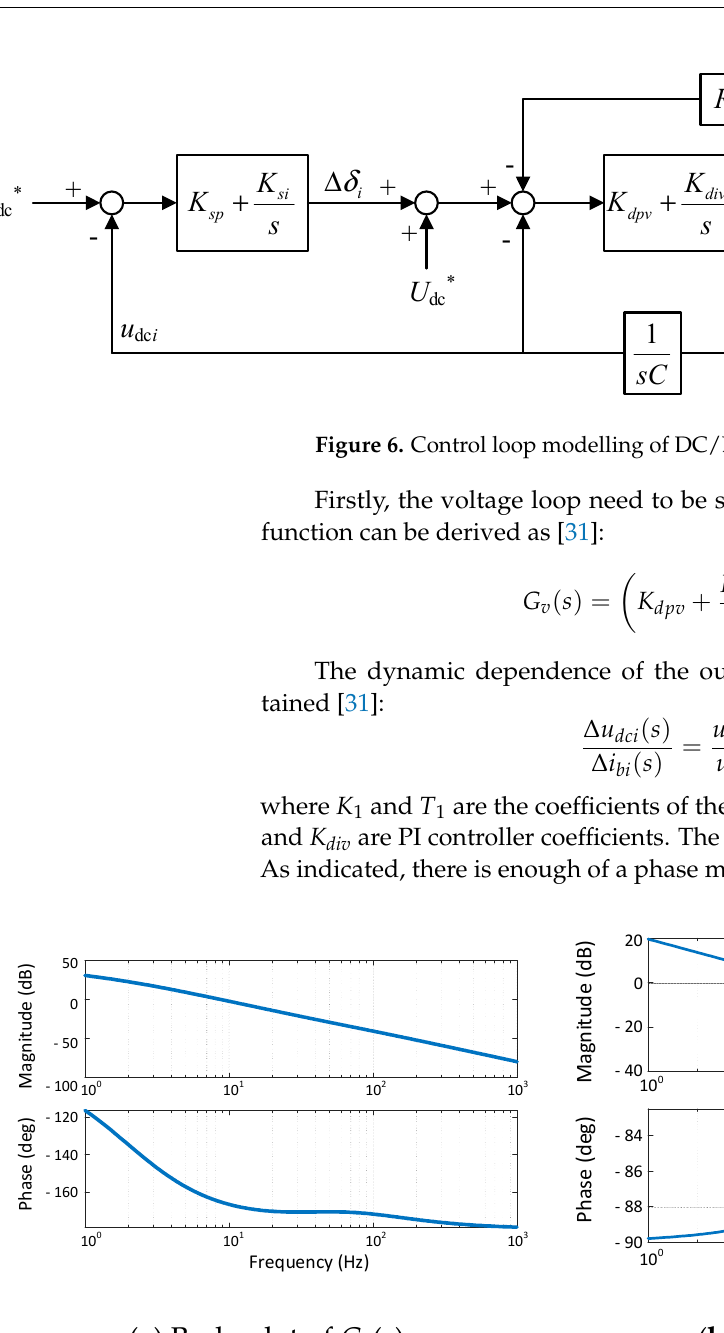
Ω , T Ω ). Figure 7. Bode plots ( K 1 = 0.85 Ω , T 1 = 0.08 s, K dpv = 0.78 A/V, K div = 3000 A/Vs and R di = 0.2 Ω ). Figure 7. Bode plots ( K 1 = 0.85 1 = 0.08 s, K dpv = 0.78 A/V, K div = 3000 A/Vs and R di = 0.2 Then, the stability of the SoC-based droop control loop is checked based on the most critical SoC-based droop coefficient, since the voltage control parameters must ensure the stability of this loop in the case of any SoC value. The open-loop small-signal transfer function represents this control loop and can be obtained from Figure 6 as Equation (9), and the corresponding bode plot is shown in Figure 7b. As can be observed, the stability of this SoC-based droop control loop can also be